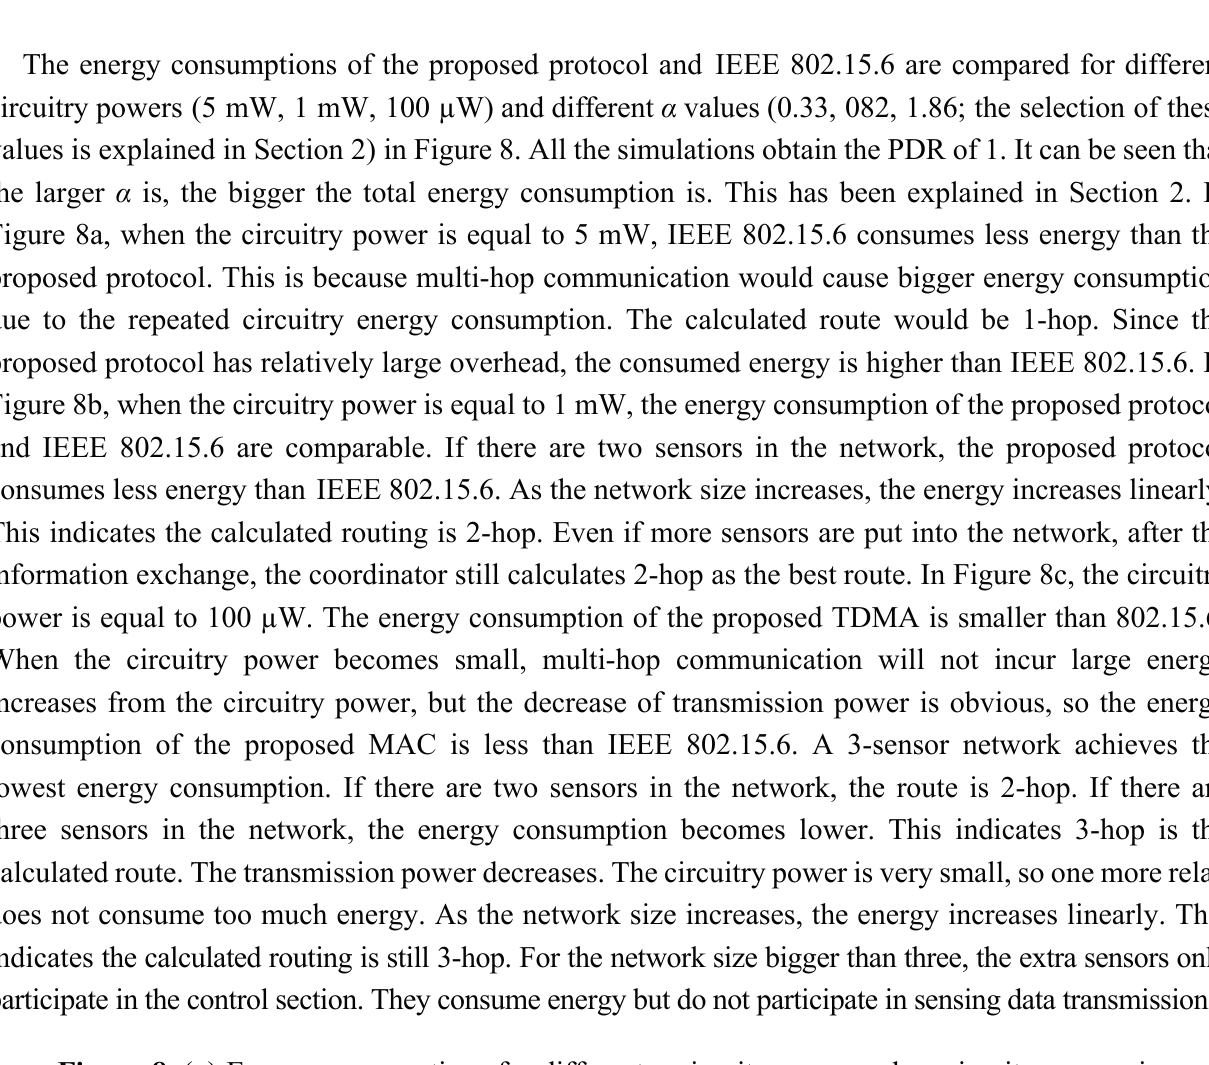
Figure 8. ( a ) Energy consumptions for different α circuitry power when circuitry power is 5 mW; ( b ) Energy consumptions for different α circuitry power when circuitry power is 1 mW; ( c ) Energy consumptions for different α circuitry power when the circuitry power is 100